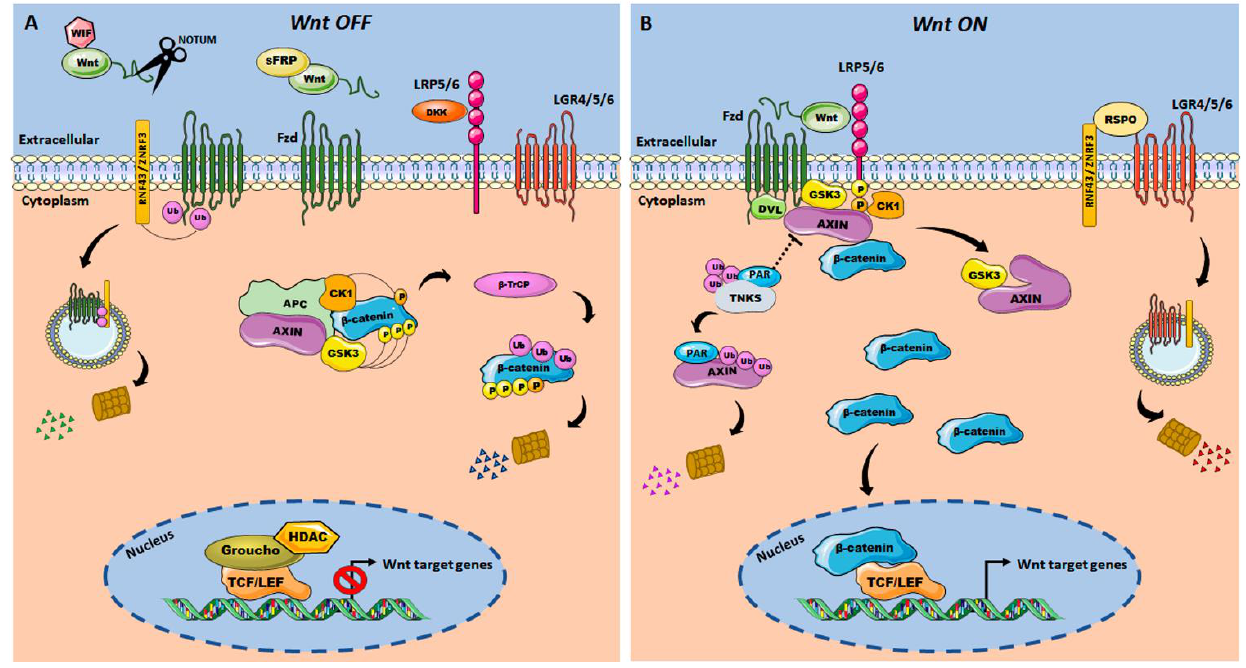
Figure 1. Schematic representation of the regulatory model of the Wnt/ β -catenin signaling pathway. ( A ) in the absence of Wnt; ( B ) after binding of Wnt ligand. WIF, Wnt Inhibitor Factor; sFRP, Secreted Frizzled-related Protein; DKK, Dickkopf; LRP, LDL Receptor-related Protein; APC, Adenomatous Polyposis Coli; CK1, Casein Kinase 1; GSK3, Glycogen Synthase Kinase-3; Dvl, Disheveled; Tnks, Tankyrases; β-TrCP, Beta-Transducin repeat-Containing Protein; β-cat, β-catenin; TCF, T-Cell Fac- tor; LEF, Lymphoid Enhancer-binding Factor; HDAC, Histone Deacetylase; TLE, Transducin-Like Enhancer Proteins; PAR, Poly-(ADP-ribose); RSPO, R-spondin; ZNRF3, E3 ubiquitin-protein lig- ases; RNF43, Ring Finger Protein 43; LGR4/5/6, Leucine-rich repeat-containing G-protein coupled Receptors 4/5/6; P, phosphorylation; Ub,